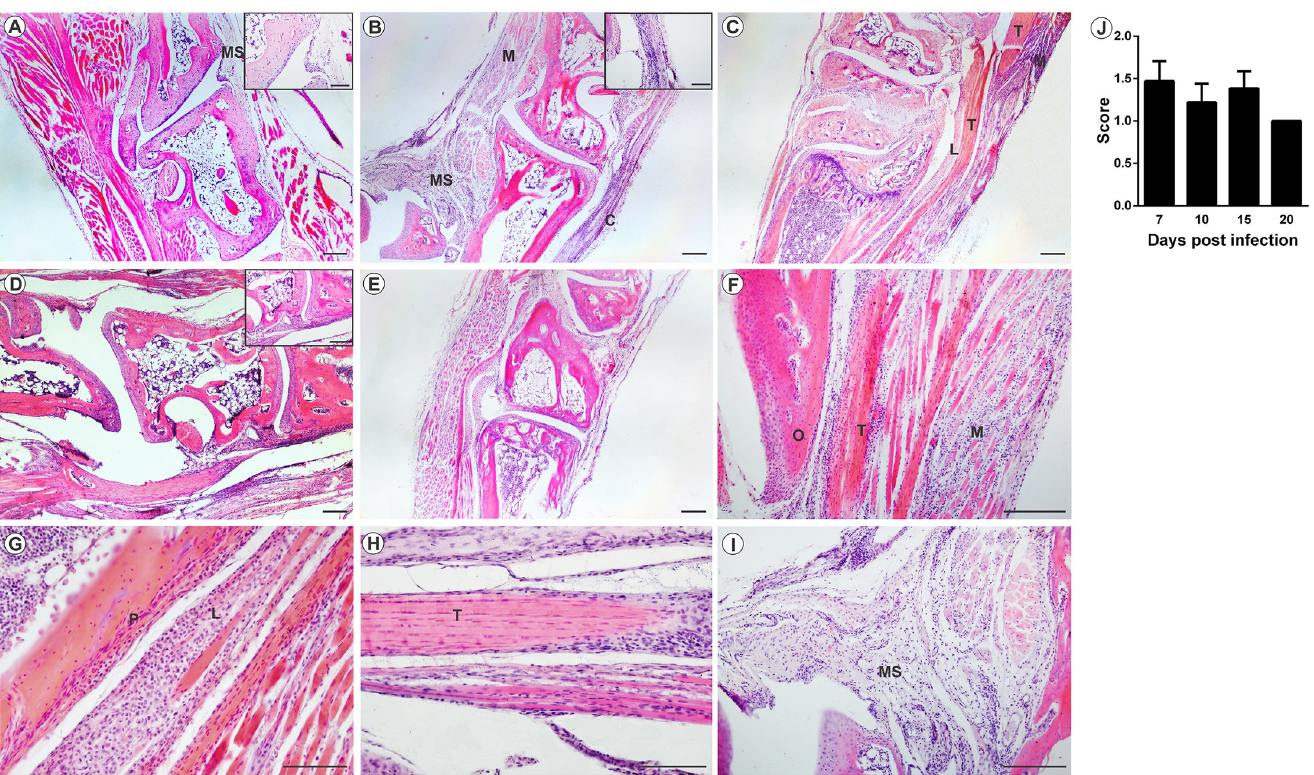
Fig 7. Mayaro virus-induced arthritis in mice infected below the right forelimb with 1.25x10 7 PFU. Animals were sacrificed at 3, 7, 10, 15 and 20 days p.i. for tissue damage analysis. The ankle joint was fixed in Karnovsky, decalcified in 10% EDTA, embedded in paraffin, and 5 μ m sections were made and stained with HE. (A) Negative control. (B) Infiltrated in the joint capsule, muscle and synovial membrane with 7 days PI. (C) Infiltrated the ligament, tendon and muscle with 10 days PI. (D) Infiltrated synovial membrane with 15 days PI. (E) MAYV infection with 20 days PI. (F) Tendonitis and myositis with 7 days PI. (G) Periostitis with 10 days PI. (H) Tenosynovitis with 15 days PI. (I) Synovitis with 7 days PI. (J) Histological score. M: muscle; T: tendon; L: ligament; B: bone; P: periosteum; SM: Synovial membrane. Images A, B, C, D, E (40X magnification, 200 μ m bar); F and I images (100X magnification), G and H images (200X magnification) 100 μ m bar. N = 3